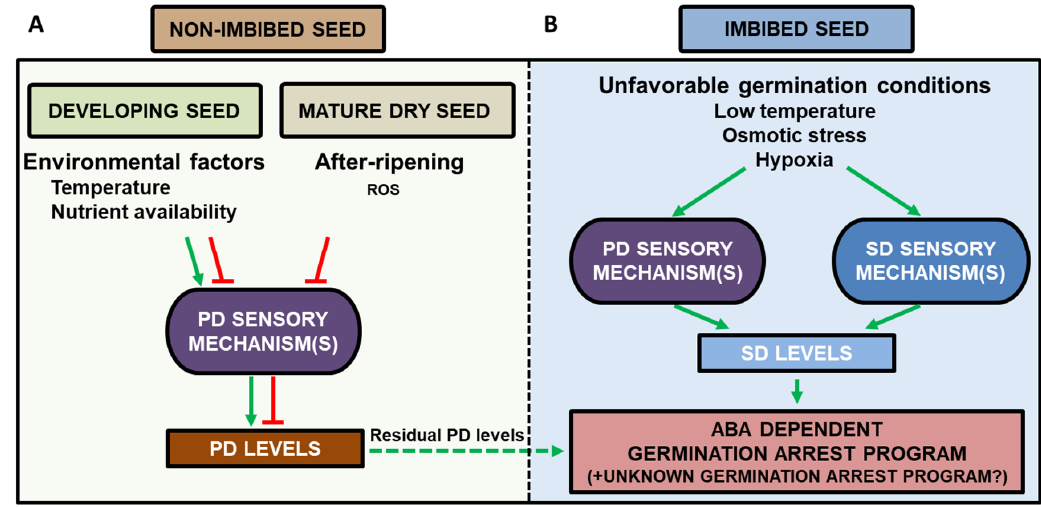
Figure 1. A working model connecting primary (PD) and secondary (SD) dormancy. ( A ) Seed development and the dry seed. The maternal environmental factors are perceived by the PD sensory mechanism(s), which determines final PD levels stored in the mature dry seed. In the mature dry seed, after-ripening processes take place, likely involving accumulation of oxidative events, lowering the PD levels. ( B ) Establishment of SD in the imbibed seed can take place in non-dormant seeds, i.e., seeds that germinate under particular, favorable seed germination conditions. Upon imbibition, continuous exposure to unfavorable environmental factors is perceived in an unknown manner. This could involve dedicated SD sensory mechanism(s) and/or the PD sensory mechanisms operating in the developing seed. In turn, the sensory mechanism promotes an increase in SD levels that activate germination arrest program(s), so that germination does not take place even under favorable germination conditions. Residual PD levels may promote the onset of SD upon seed imbibition (dashed line). Seeds may cycle between non-dormant and SD.